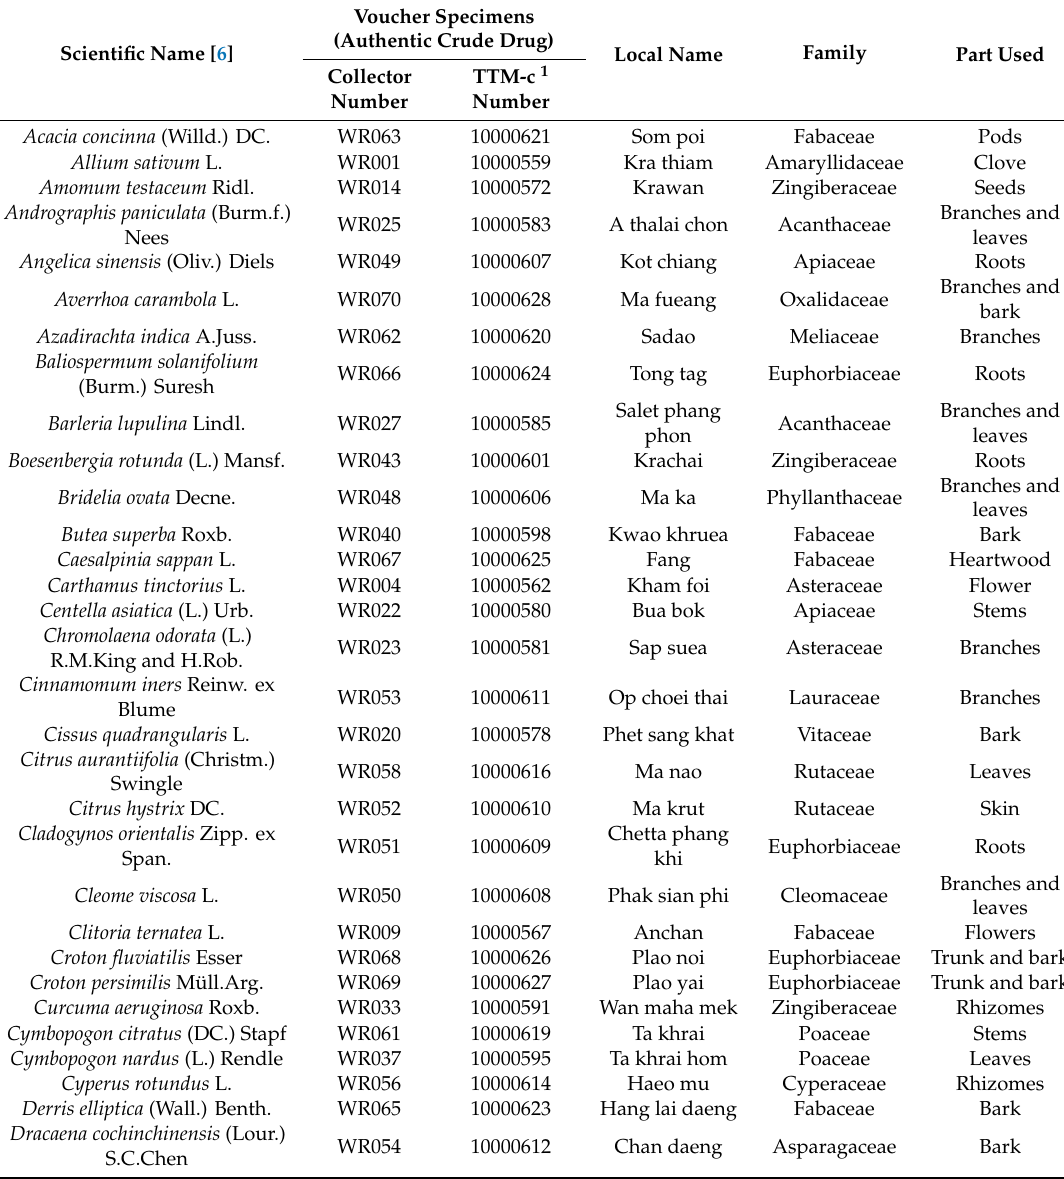
Table 1. List of the selected Thai medicinal